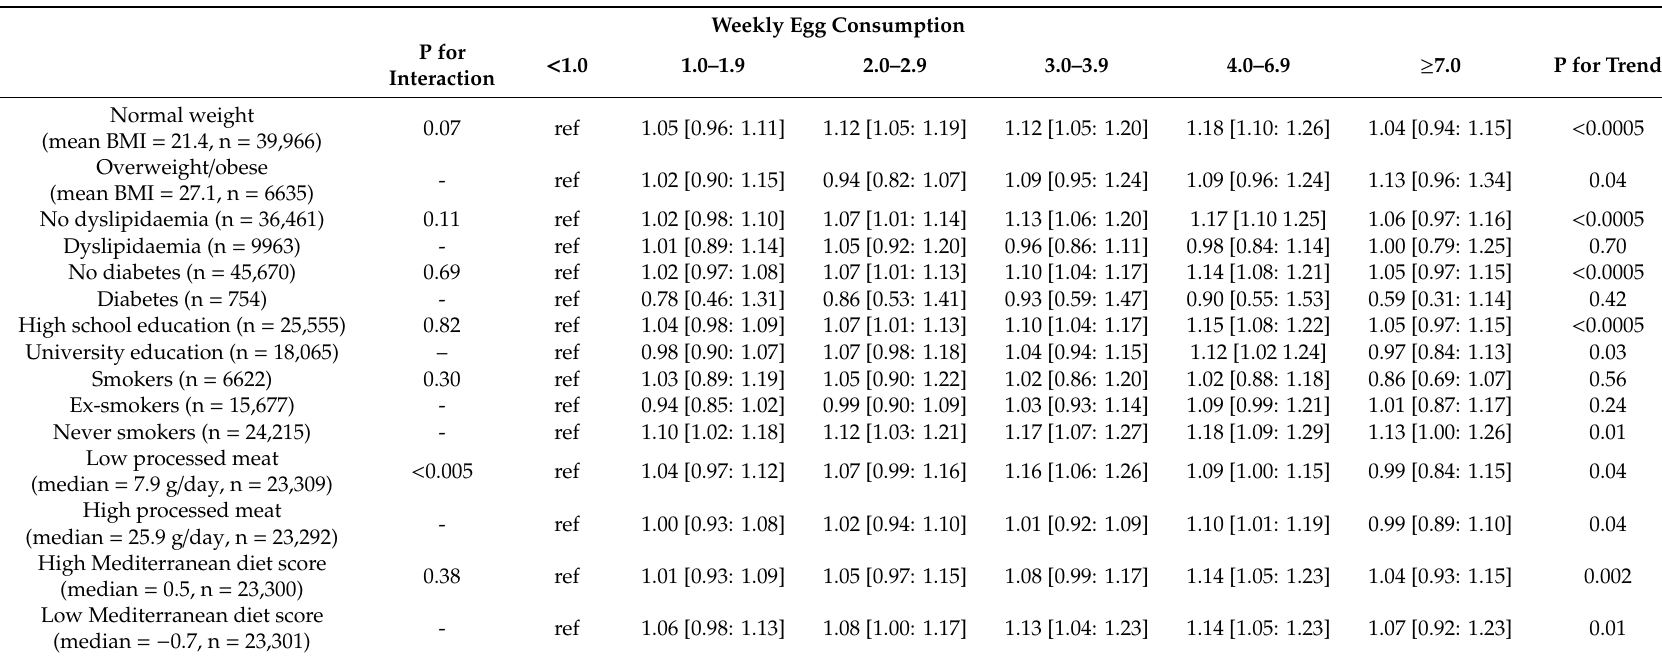
Table 3. Subgroup analysis: stratified multivariate cox proportional hazard models for incident hypertension risk related to weekly egg